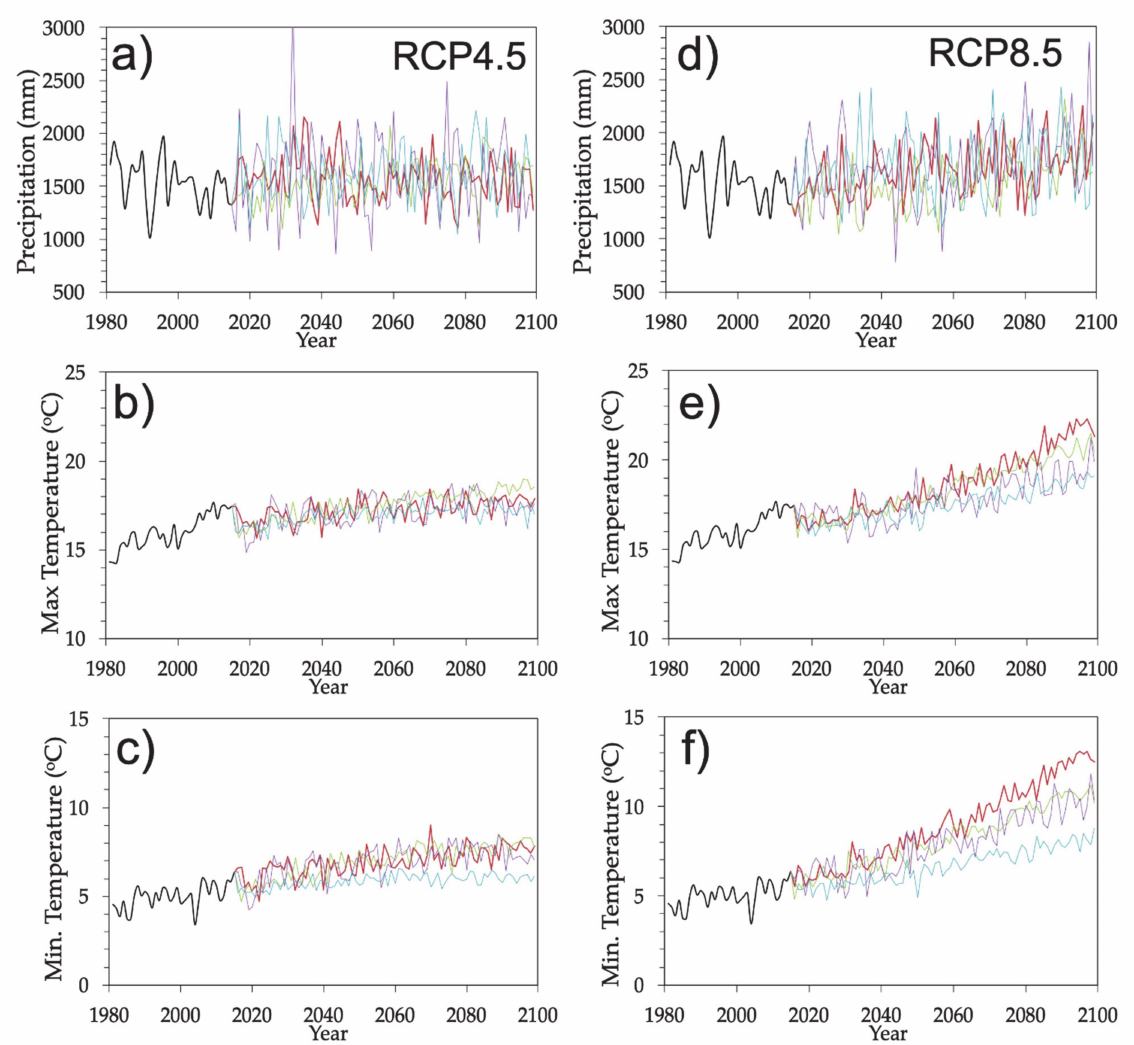
Figure 6. Precipitation and temperature (observed, bias corrected) of RCP 4.5 ( a – c ) and 8.5 ( d – f ) of the selected GCMs; black (baseline), red (MIROC/MPI), blue (GFDL), green (HadGEM), and purple